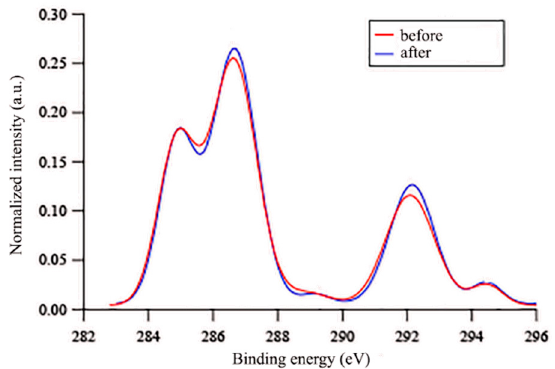
Figure 9. Area-normalized C(1s) XPS signals at φ = 70° for the film E13-S27Sz A 11_100 before and after 7 days of immersion in water.